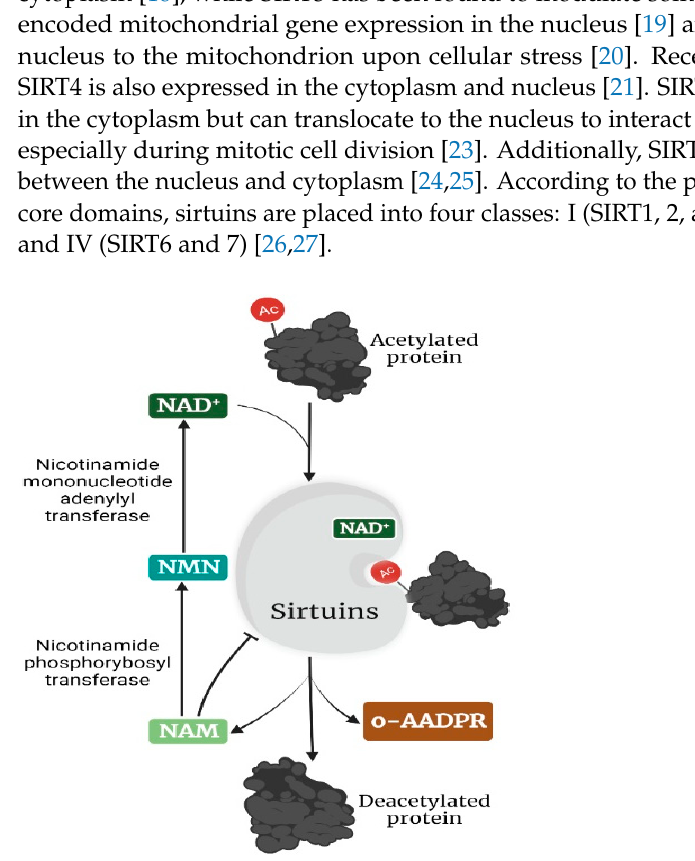
Figure 1. Mechanism of deacetylation of targets by sirtuins. In the presence of the co-factor NAD + , the acetylated protein target is deacetylated by sirtuins, producing a deacetylated protein, o-AADPR, and NAM, a feedback inhibitor of sirtuins. NAM is reconverted through NMN to NAD + in two enzyme-catalyzed steps. The image was created with BioRender.com .